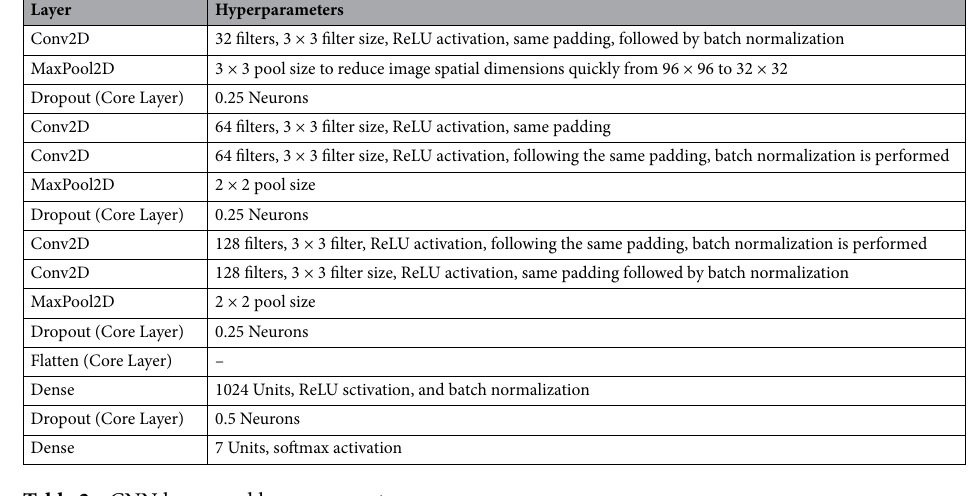
Table 2. CNN layers and hyperparameters